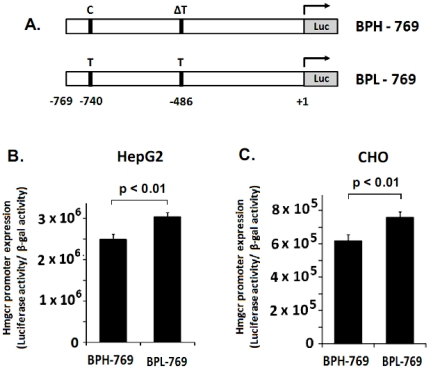
Role of the C-740T and ΔT-486T SNPs in the differential activity of Hmgcr promoter.The BPH-769 and BPL-769 promoter/firefly luciferase reporter constructs harboring C/T SNP at the −740 bp position and ΔT/T SNP at the −486 bp position (panel A) were generated as described in the Materials and Methods section. These constructs were transfected into HepG2 and CHO cells, along with co-transfected β-galactosidase expression plasmid. Cells were lysed 24–30 hrs after transfection and assayed for luciferase activity as well as β-galactosidase activity. Values shown in the bar graph are the Means ± S.E. of normalized luciferase activity (ratioed with respect to β-galactosidase activity) from at least three independent experiments. The BPL promoter displayed significantly higher activity than the BPH promoter in HepG2 (panel B) and CHO cells (panel C).